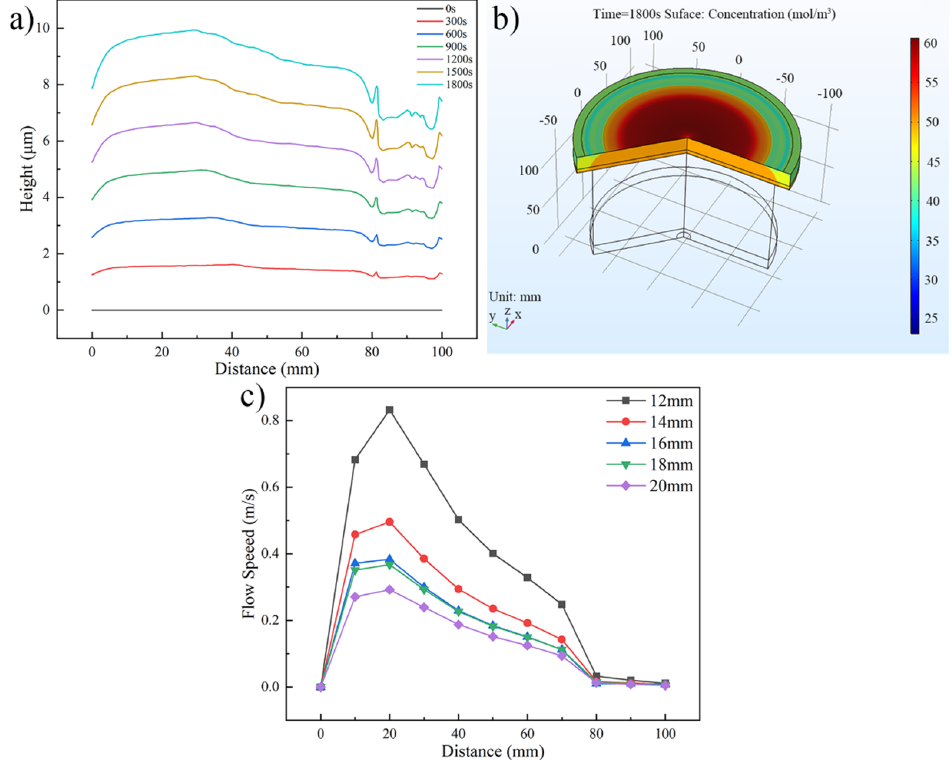
Figure 4. Distributions of the Au bump height, Au+ concentration, and flow speed. ( a ) Au bump height distribution along the wafer radius (inlet diameter is 12 mm), ( b ) Au+ concentration distri- bution on the wafer surface (inlet diameter is 12 mm), and ( c ) flow speed distribution on the wafer surface at different inlet diameters.